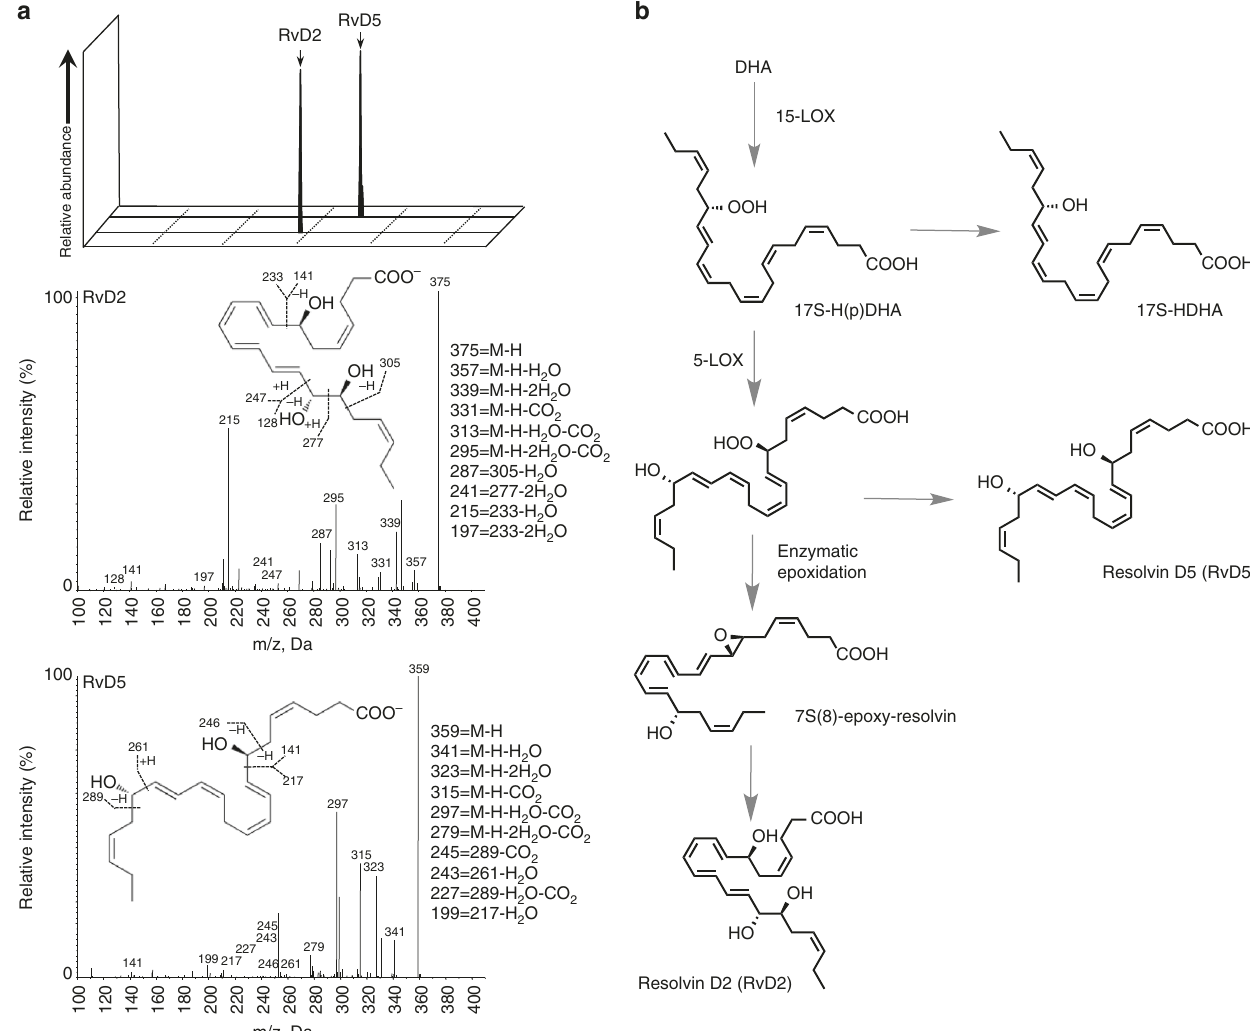
Fig. 1 Identi fi cation and biosynthetic pathway of RvD2 and RvD5. a Human M1 and M2 (5 × 10 6 cells/ml PBS + Ca/Mg) were incubated for 90 min with E. coli (O6:K2:H1; ratio 1:50) at 37 °C. Lipid mediators were isolated by SPE and analyzed by LC – MS – MS. Representative MRM and MS – MS of RvD2 and RvD5 from n = 7. b Biosynthetic pathway of RvD2 and RvD5 from